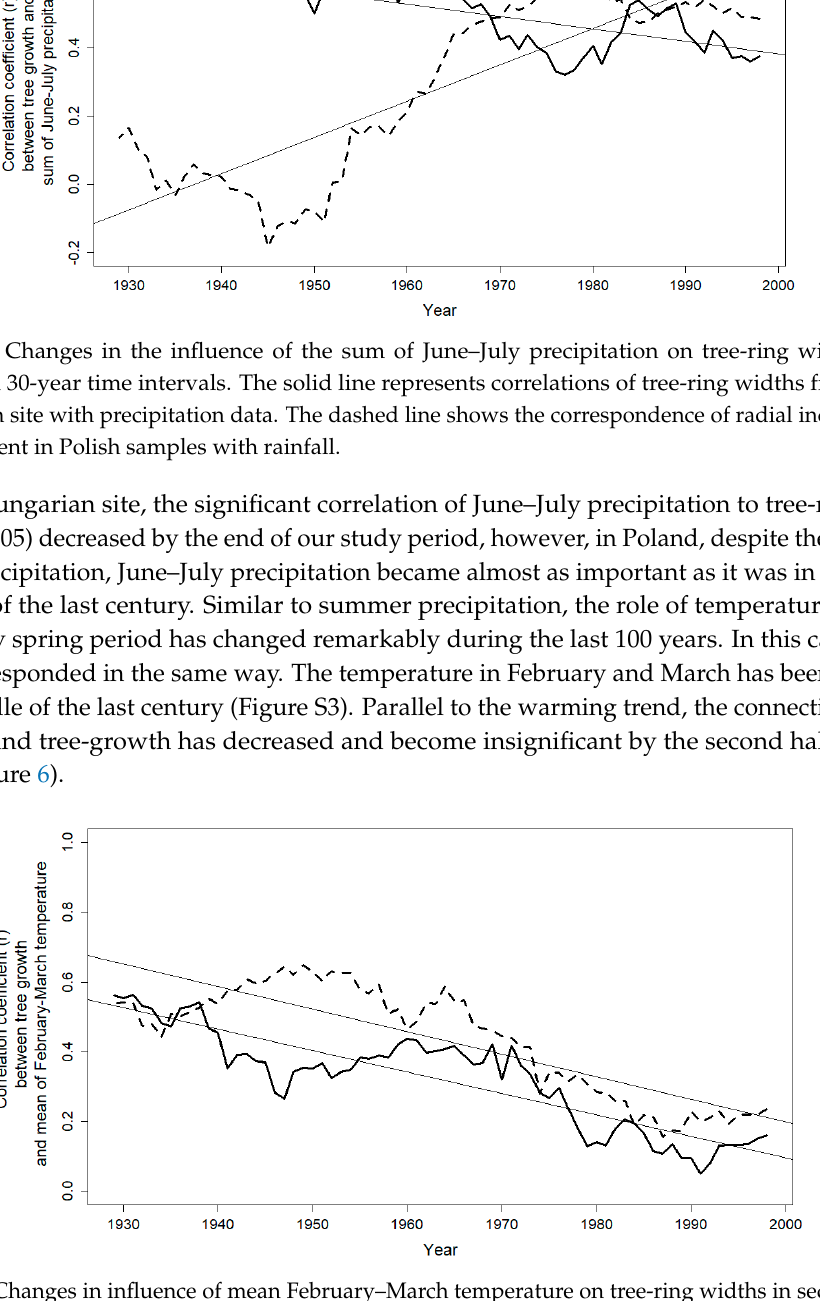
Figure 6. Changes in influence of mean February–March temperature on tree-ring widths in sequential 30-year time intervals. The solid line shows the correlation variability between tree-ring widths and temperature data at the Hungarian site, the dashed line represents the changing correspondence of thermal conditions to tree-ring growth in Polish site.